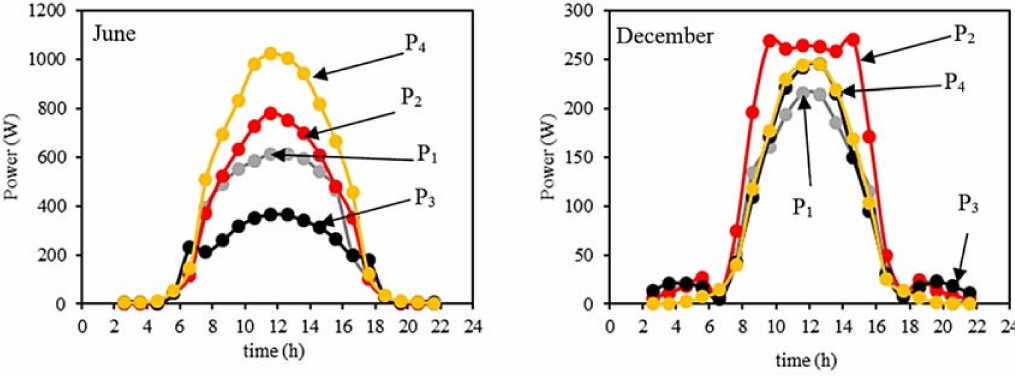
Figure 16. Collected energy per unit time along the solstices for the standard and proposed structures, when tilt is 30 ◦ in